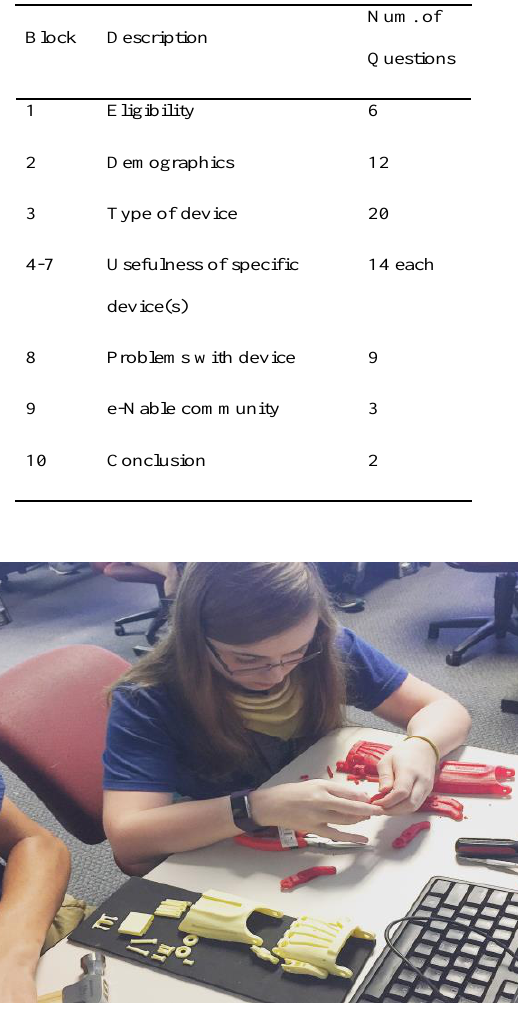
Figure 1: Volunteer assembling a 3D-printed prosthetics